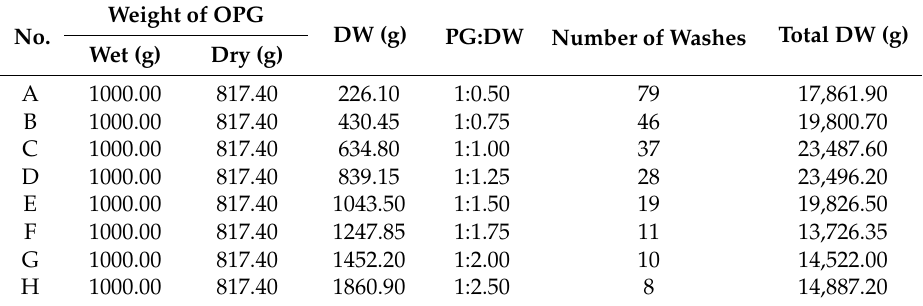
Table 3. Mix proportions of OPG samples.